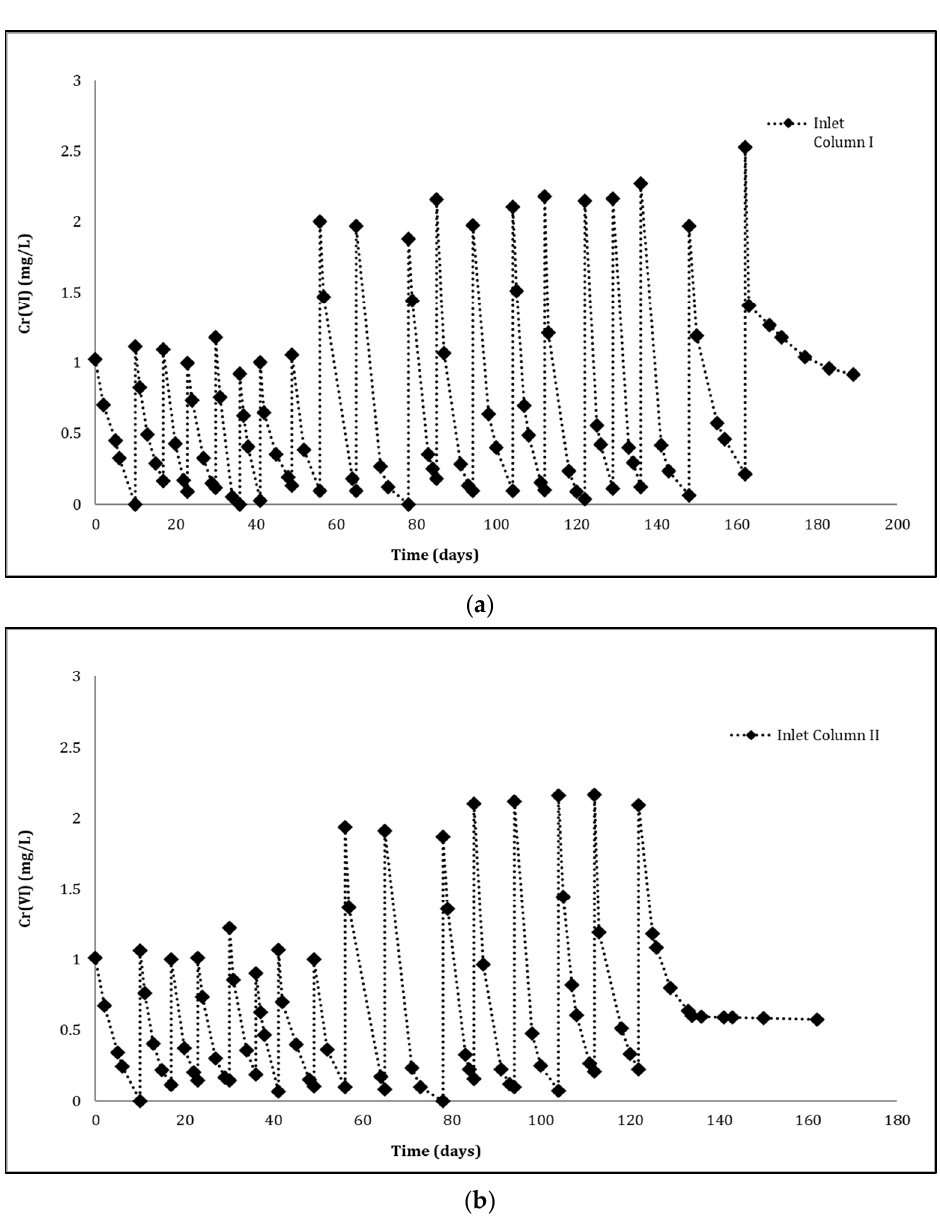
Figure 4. Cr(VI) profiles in the inlet of Columns I ( a ) and II ( b ) in the Biotic-Abiotic experiment after the addition of the carbon sources.